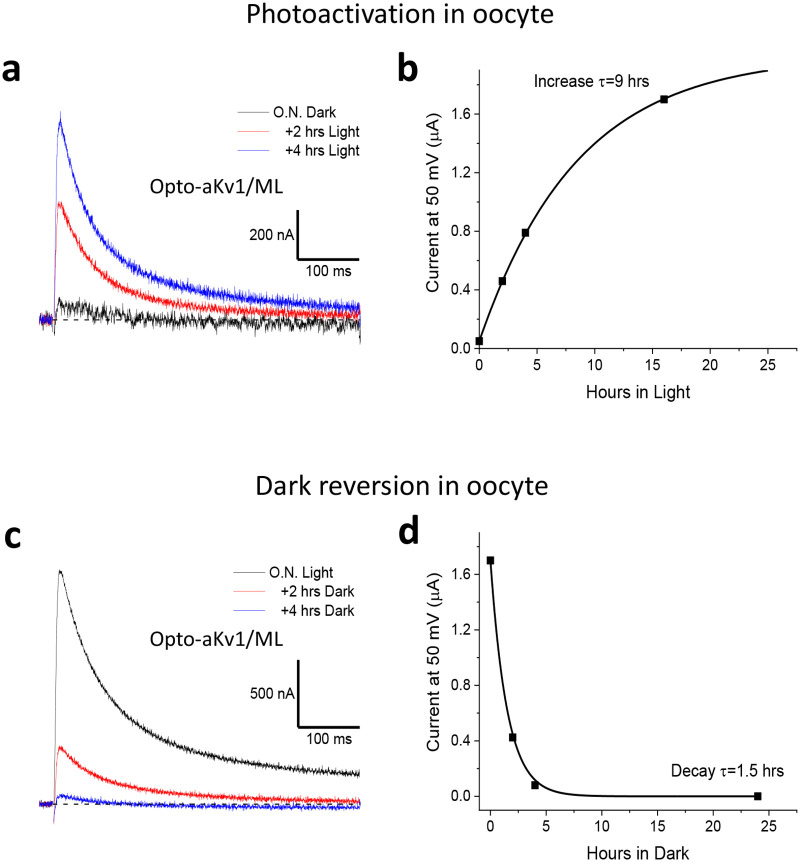
Time course of photoactivation and deactivation in oocytes.Opto-aKv1/ML channels were expressed in Xenopus oocytes overnight in the dark or with blue light exposure. Currents were elicited by +50 mV depolarization from -100 mV holding potential. a) Photoactivation of current. Oocytes incubated in the dark overnight expressed very little current; however, progressively longer exposure to blue light led to increasing current expression. b) Time course of photoactivation in an individual oocyte. Induction of current by blue light is significant within 2 hours of exposure and follows a 9 hr time constant. c) Deactivation by darkness. Oocytes exposed to blue light overnight were left in the dark and then tested at the described time points. d) Single exponential fit to dark deactivation of induced current shows a 1.5 hr time constant to return to baseline.